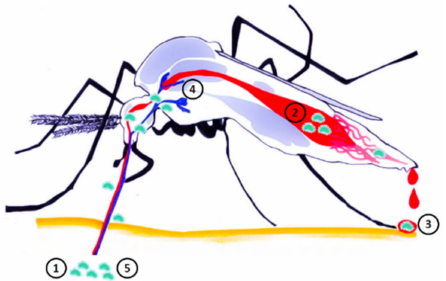
Figure 3. F. tularensis possible localizations inside mosquitoes and corresponding modes of trans- mission to humans. Mechanical contamination cycle via mosquito dejection: F. tularensis is ingested during a blood meal in an infected host 1 (cid:13) , the bacterium ingested is located in the